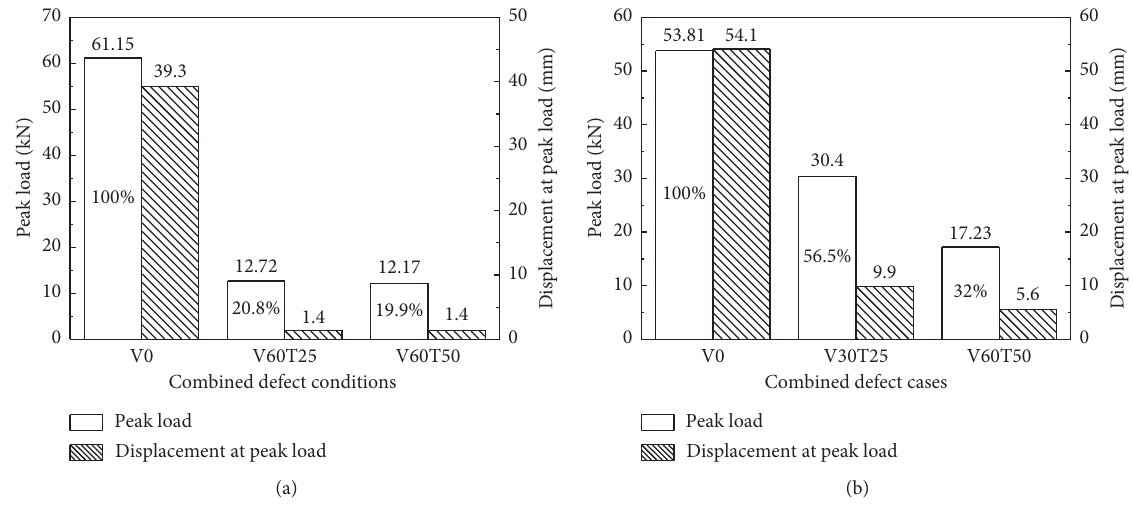
Figure 15: Peak load and displacement at the peak load of the lining with combined defects: (a) crown and (b)